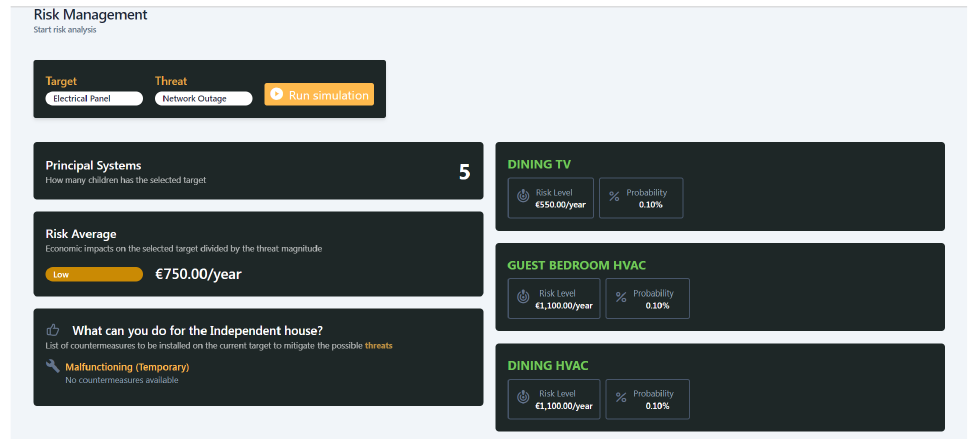
Figure 9. Scenario selection Risk GUI.